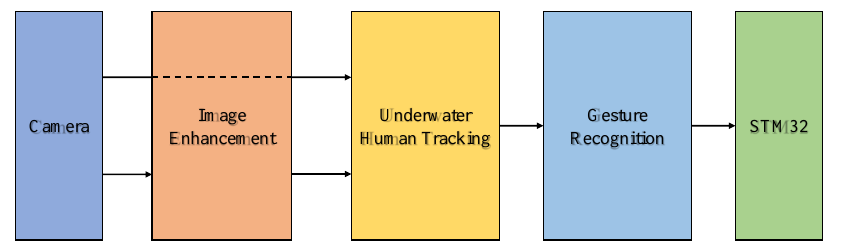
Figure 1. Gesture-based control